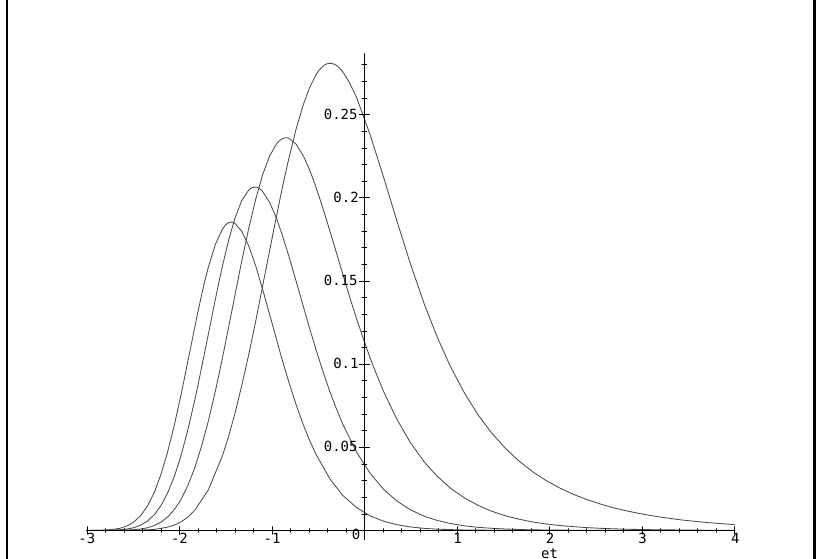
h for large values of h (cid:5) (cid:1)